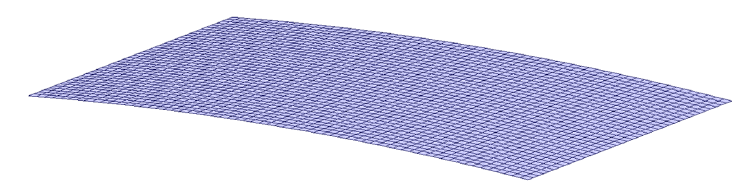
Figure 6. Finite element model of the curved